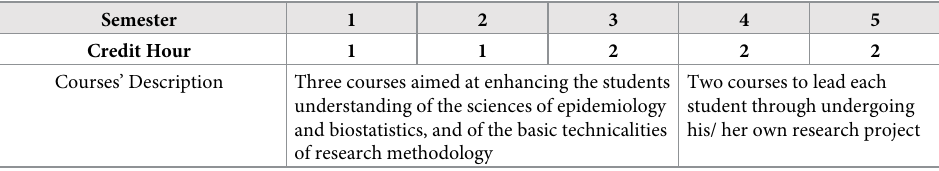
Table 1. Illustrating the outline of the research module under investigation.